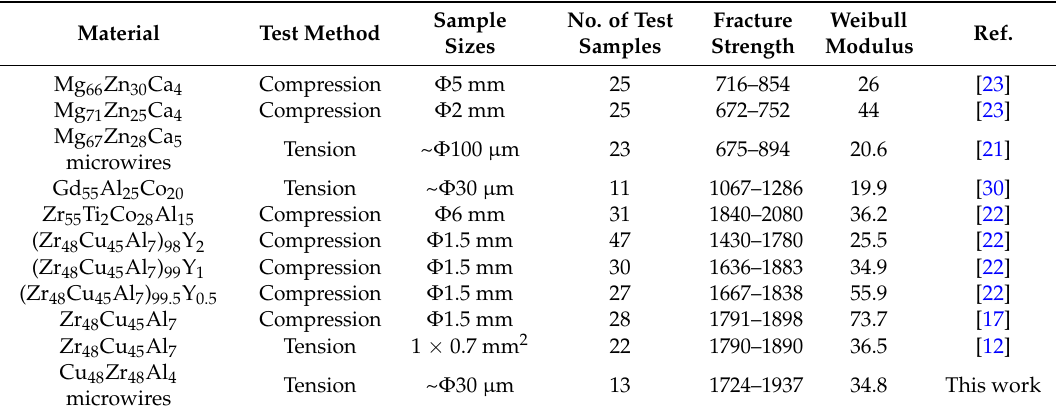
Table 2. Summary of fracture strength and the Weibull modulus of BMGs based on two-parameter Weibull model.